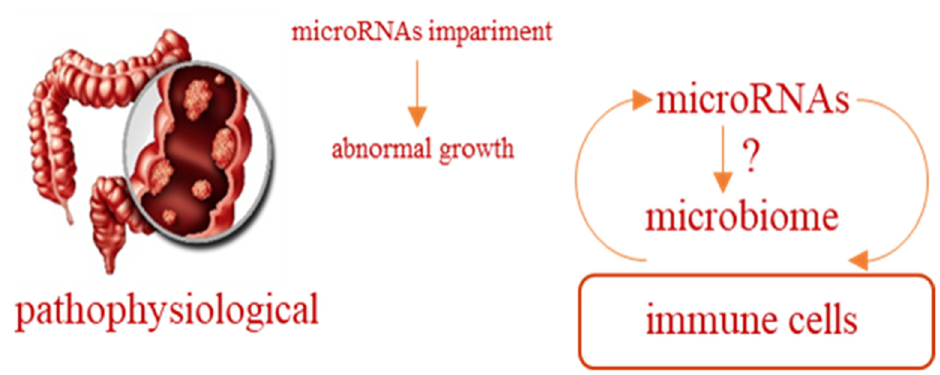
Figure 3. Poor resistant starch in diet as a promoting factor of colon cancer.